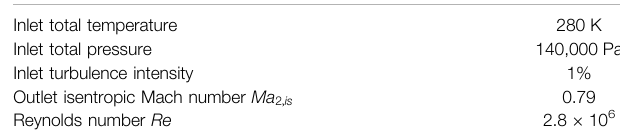
TABLE 2 | The fl ow conditions in the experiment (Sieverding et al., 2003).